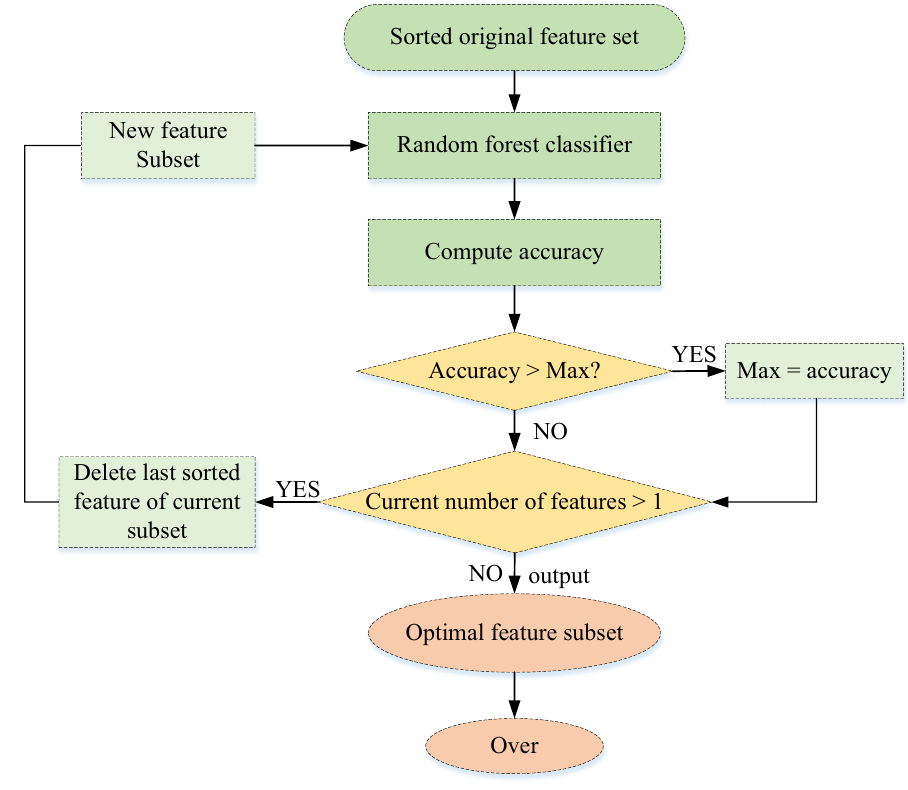
Fig. 3 Flowchart of Wrapper algorithm